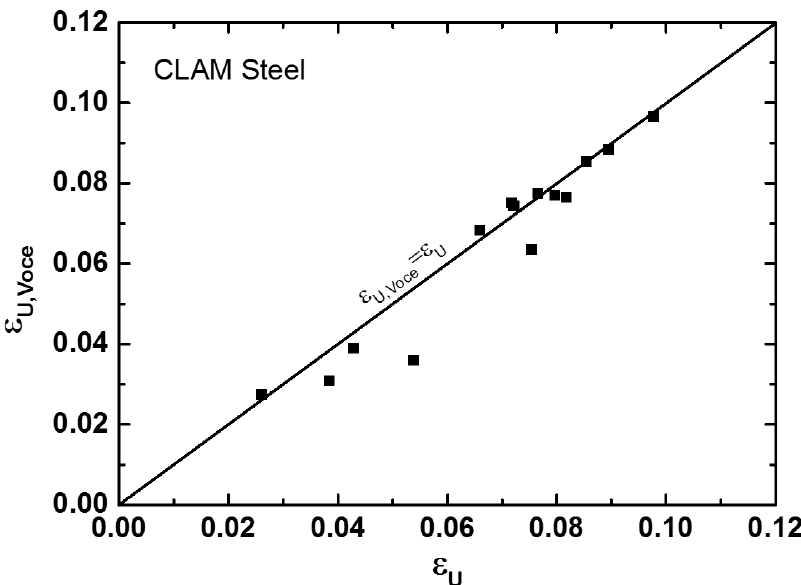
Figure 11. Comparison of predicted true uniform plastic strain ( ε U , Voce ) and experimentally detected true uniform plastic strain ( ε U ) at different temperatures in China low activation martensitic (CLAM) steel.